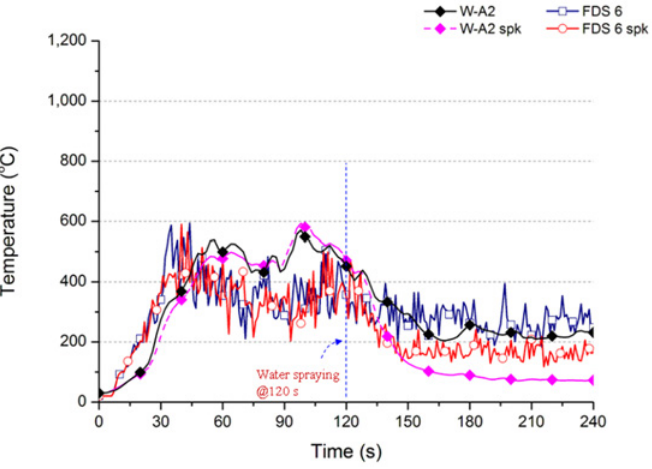
Fig 12. Temperature variation of experimental and numerical simulation cases (for FDS